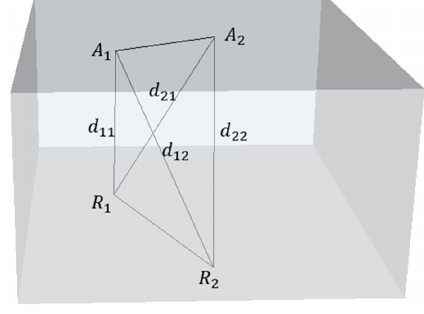
Figure 1. Access Point (AP) Deployment—Case 1.